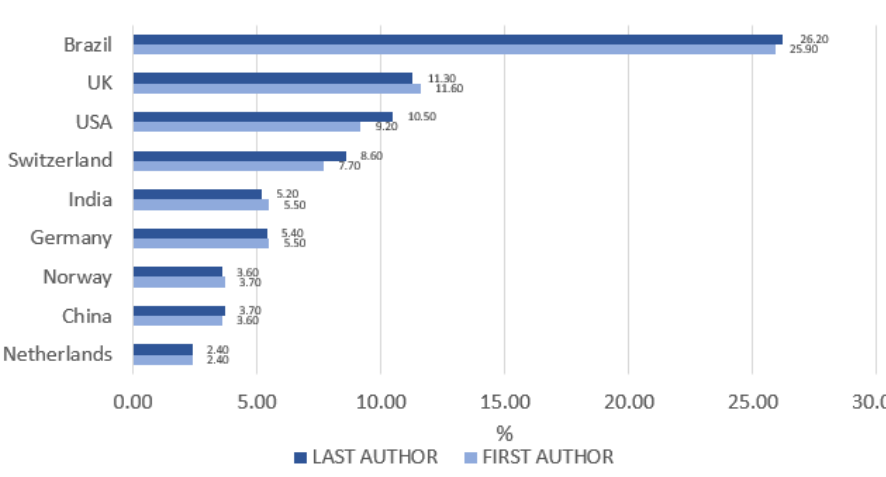
Figure 4. Origin of the articles published during the 10 years of the studied period. 3.2. Parameters Based on the Title of the Article The sample for this investigation consisted of 1090 articles published in more than 200 different journals. English was the language of publication in 97.2% of the articles. The relative weight of each year of the period regarding the proportion of the articles over the total was variable, between 6% in 2011 and 13% in 2014. When analyzing the type of article, we observed that 79.4% of all publications were research articles. Figure 5 describes in detail the different designs of the items in the sample.